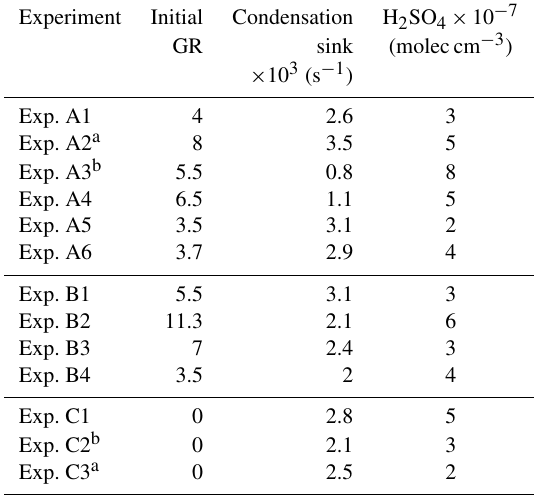
Table 2. Nucleation time, nucleation rate, and condensation rate in the experiments where NPF was observed in the perturbed